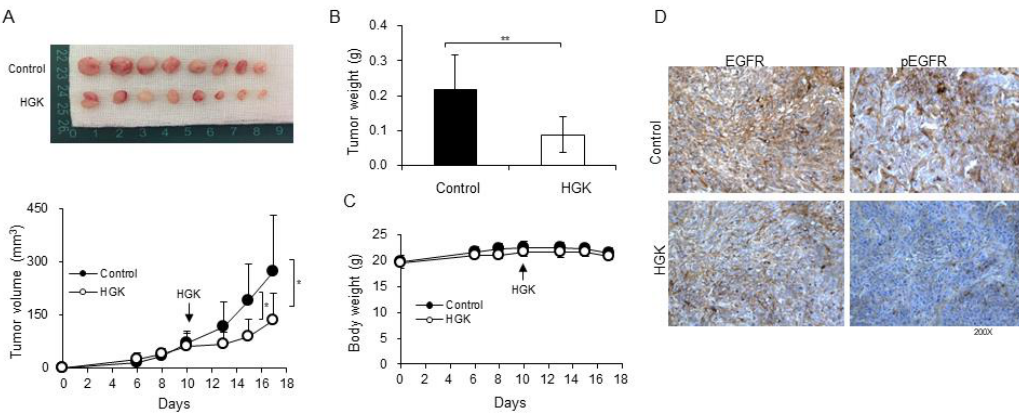
Figure 4. The antitumor effects of HGK in vivo. ( A ) The H1975 cells were inoculated subcutaneously in the right flank of nude mice. When the H9175 xenograft tumors reached around 50 mm 3 at day 10 (as indicated by arrow), HGK was intraperitoneal injected every two days. The tumor volume was detected as described in Materials and Methods and is shown in the bottom panel. The excised xenograft tumors are shown in the upper panel. The effects of HGK treatment on the tumor net weights and body weights of mice are shown in ( B ) and ( C ), respectively. ( D ) Immunohistochemical staining of xenograft tumor sections for EGFR and phosphor-EGFR (pEGFR). The data that are shown in A B, C are presented as mean ± SD and they were analyzed by Student’s t -test. Asterisks denote statistically significant.